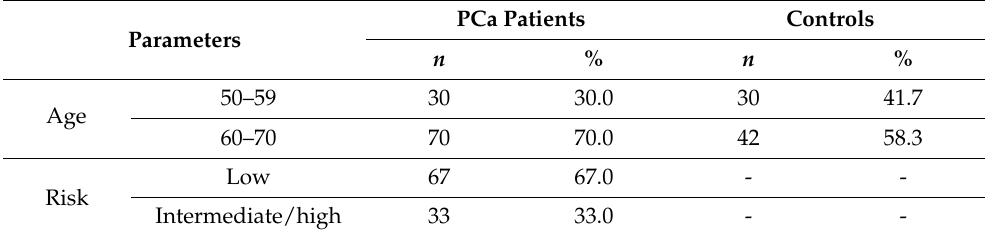
Table 1. Characteristics of PCa patients and